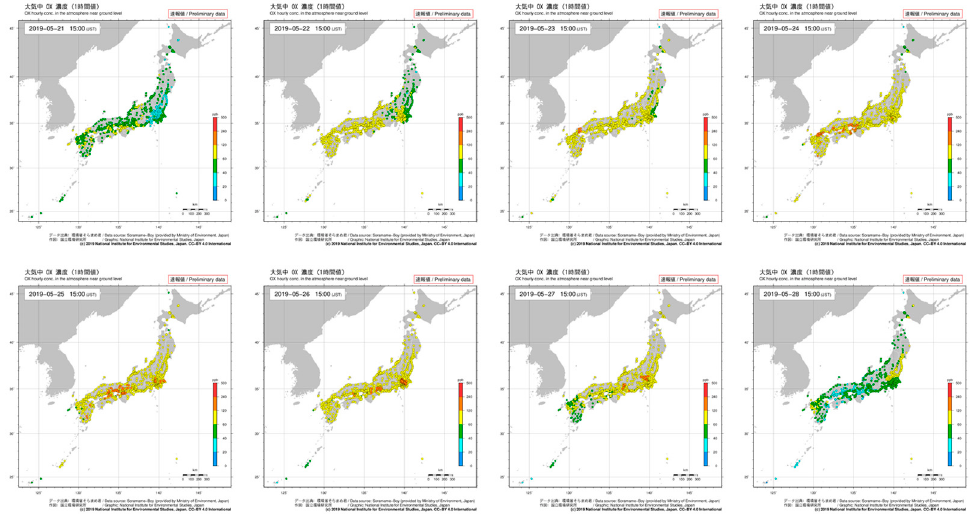
Figure 9. Distribution of ozone concentration at 15:00 (local time) from 21 May to 28 May 2019 [20].